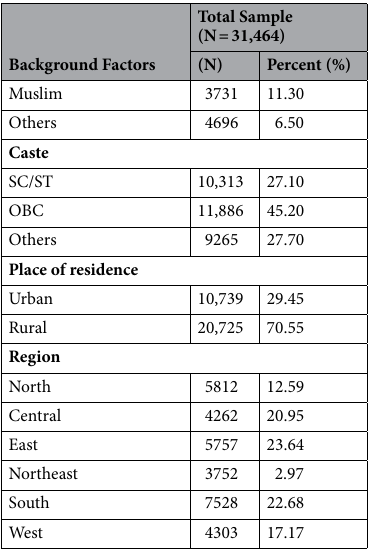
Table 1. Background characteristics of the study participants, LASI Wave 1, 2017–18. % Weighted percentage, Individual sampling weights given in LASI wave 1, 2017–18 were applied, counts (N) are un-weighted. SRH self-rated health, ADL activities of daily living, IADL instrumental activities of daily living, MPCE monthly per capita consumption expenditure. # Currently unmarried category comprises widowed, divorced, separated, deserted and never married older individuals. ## Category of living with others consists of those older adults who were co-residing either with their spouse and children, living with spouse and other relatives, and living with children and/or other